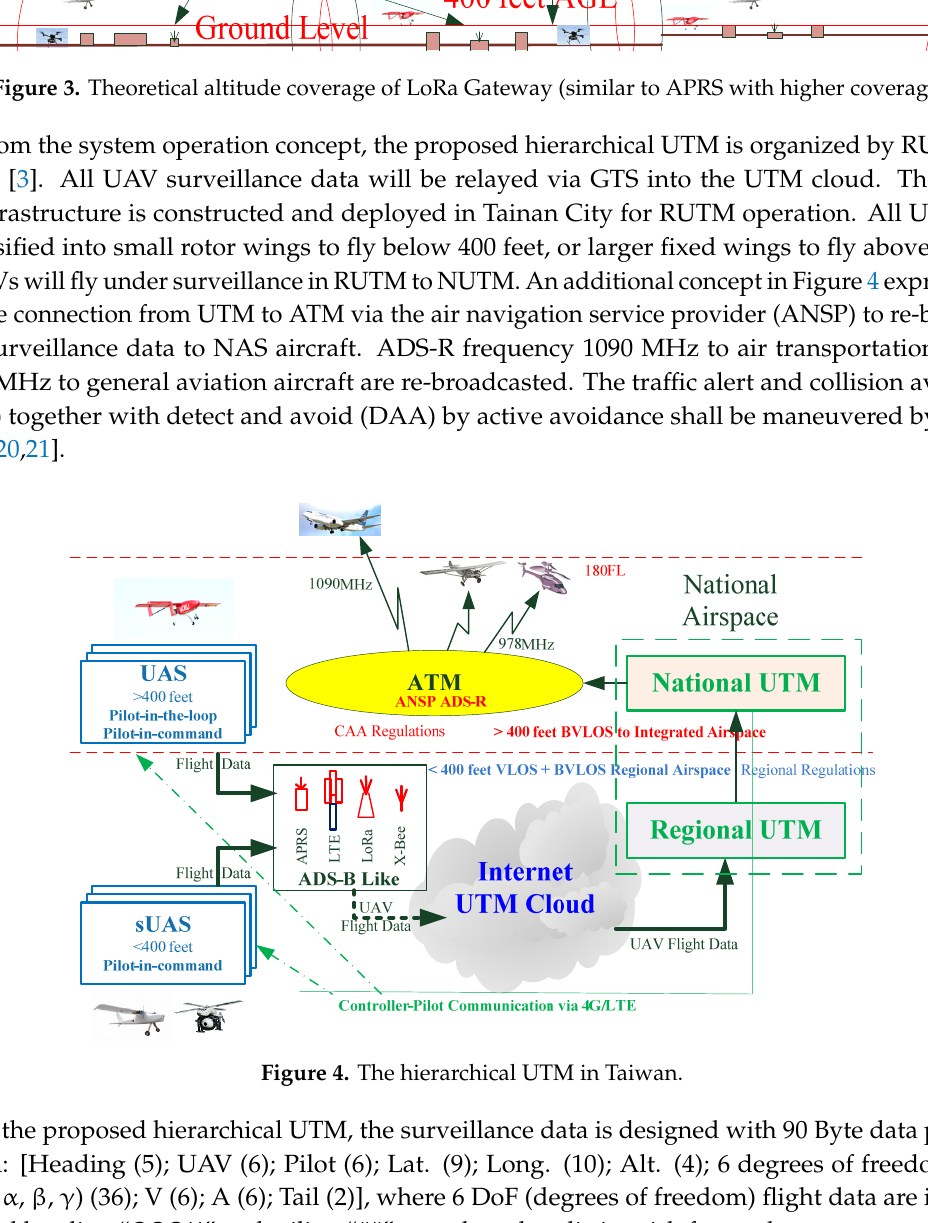
Figure 3. Theoretical altitude coverage of LoRa Gateway (similar to APRS with higher coverage).